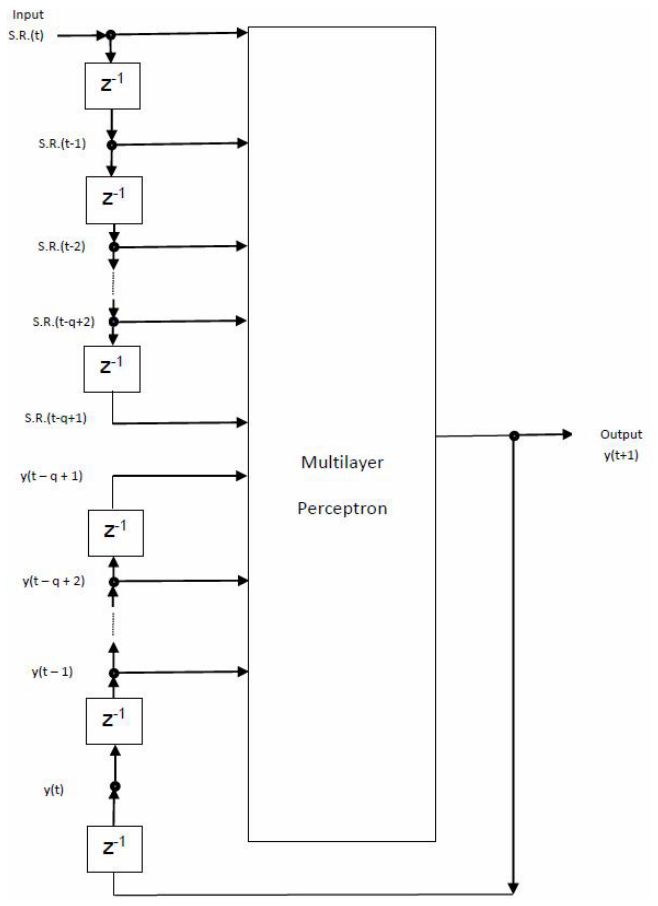
Figure 11. Architecture of the